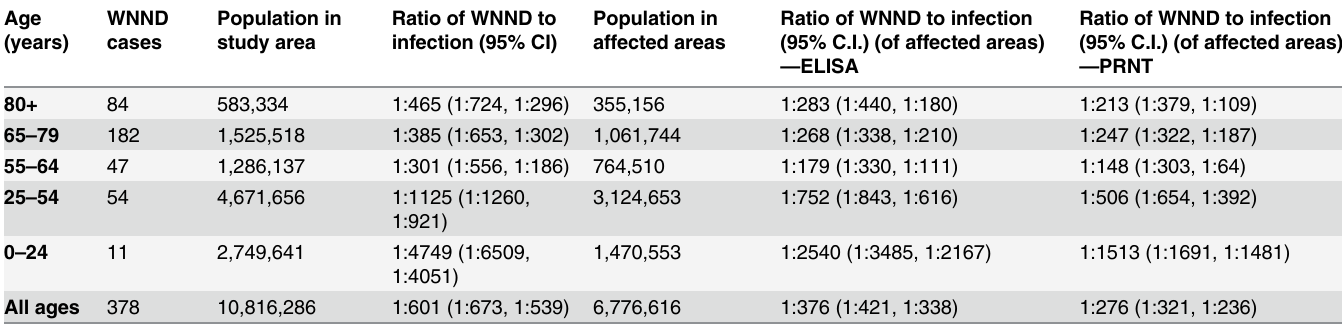
Table 4. Ratio of West Nile neuroinvasive disease (WNND) to infection by age-group. Age WNND (years)